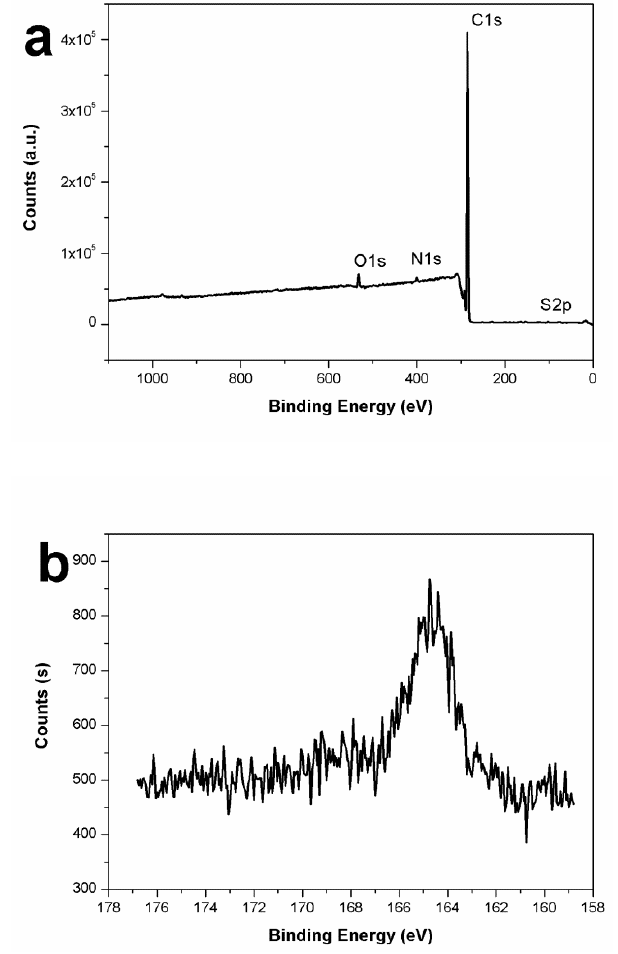
Figure 11. XPS spectra of typical PAT-PS particles (run 4): ( a ) total spectrum; and ( b ) S 2p spectrum.